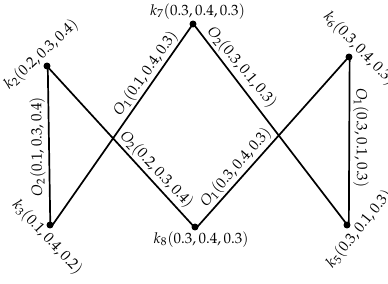
Figure 3. An IN induced-subgraph